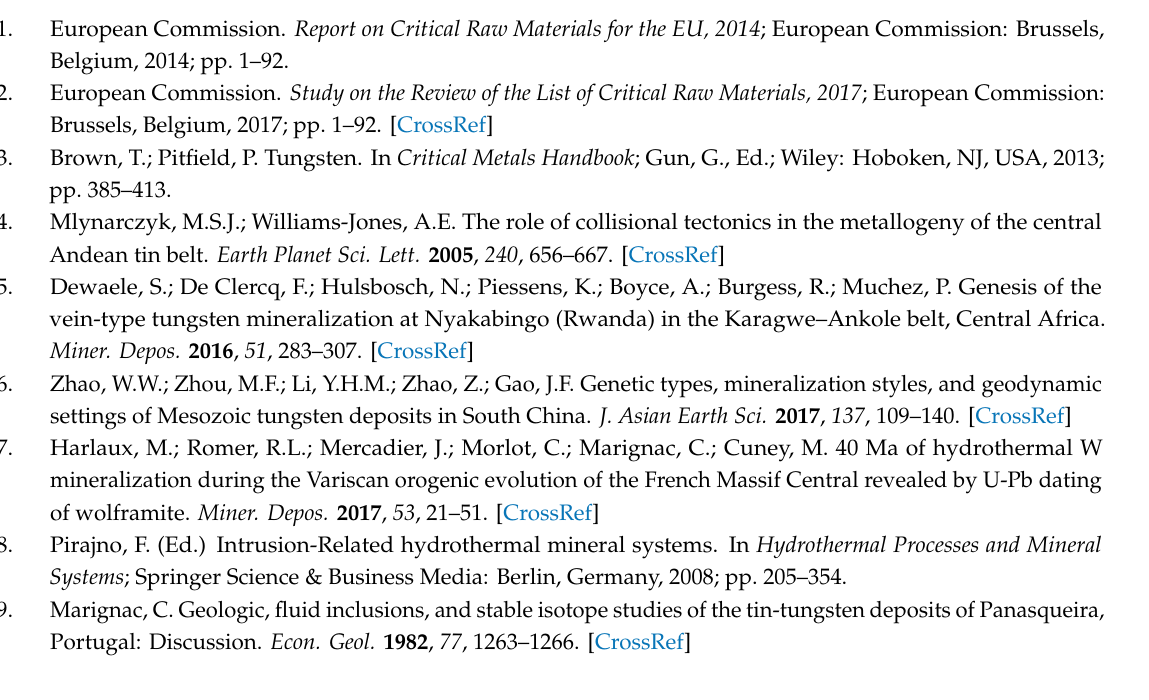
Figure S1. Mineral paragenesis for the di ff erent episodes that a ff ected the Echassi è res district in the Beauvoir and Colettes granites and the La Bosse stockwork (A), and in the proximal veins and schist host rock (B). For best visibility, the metamorphic minerals (Metam.) are not listed in (B), as they are the same as in (A). Age compilation after